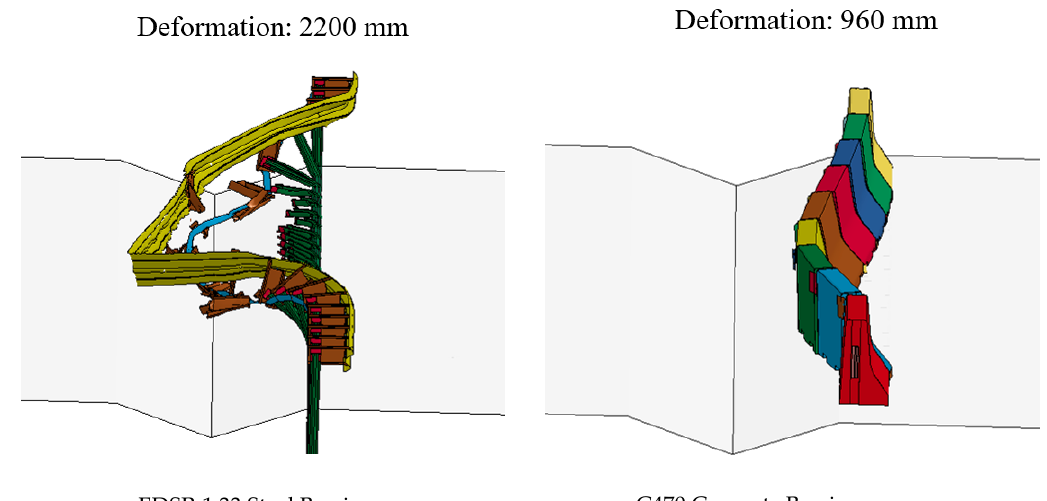
Figure 13. Comparison of damage to steel EDSP-1.33 and concrete C470 barriers after the bus impact simulation (front view).